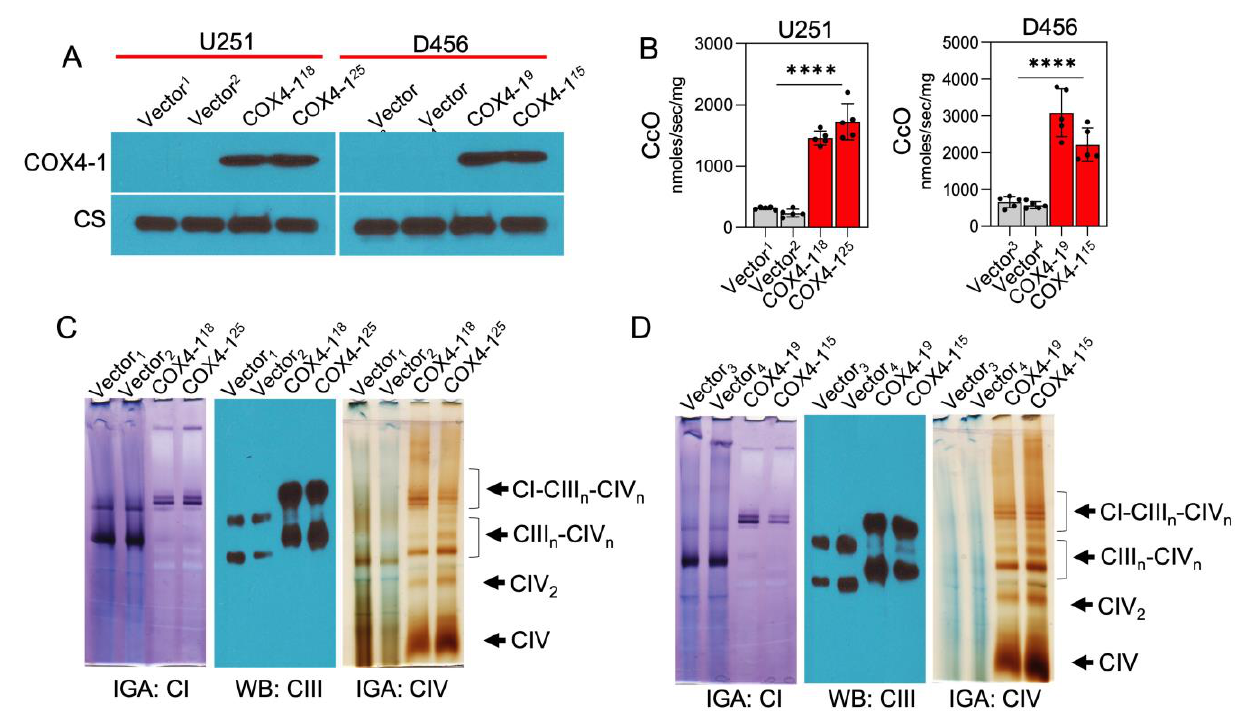
FIGURE 5: COX4-1 overexpression promotes SC assembly in radiosensitive GBM cells. (A) Representative Western blot showing COX4-1 ex- pression in U251 and D456 cells stably transfected with vector only or vector expressing COX4-1. Citrate synthase (CS) served as the loading control. (B) Quantification of CcO activity in vector control- and COX4-1-transfected U251 and D456 cells. Data are presented as the mean ± SEM (n=4). (C) Digitonin-solubilized mitochondria from the indicated cell lines were subjected to BN-PAGE followed by in-gel complex I and IV activity assays and complex III Western blot analysis. Representative images from 3 separate experiments. p < 0.0001 (****), calculated by Student